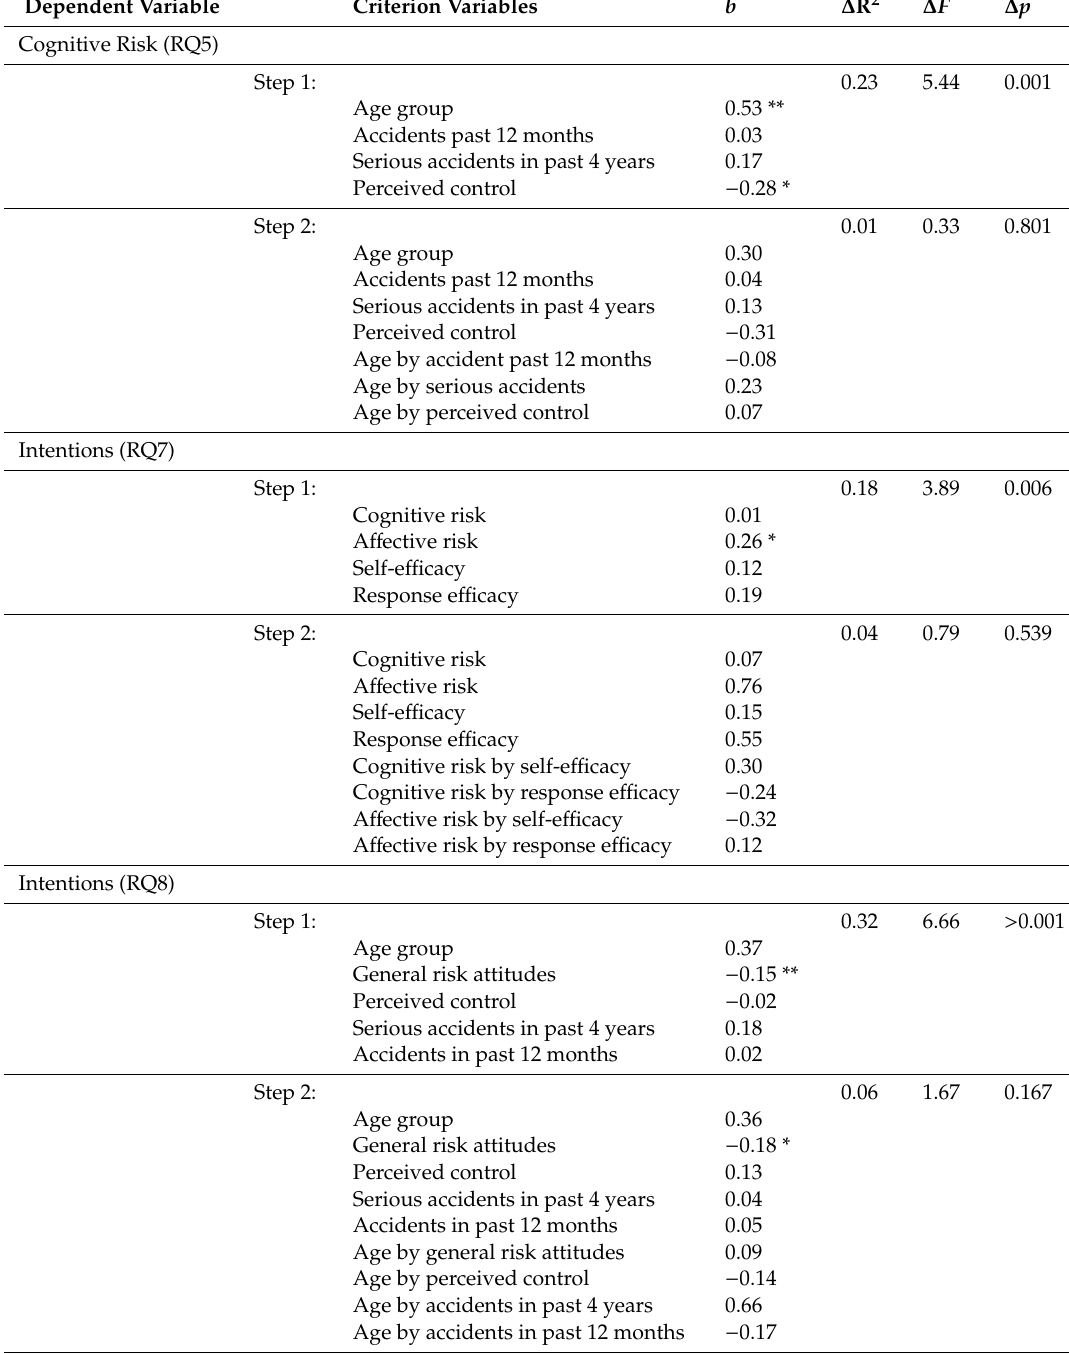
Table 2. Output details from the three hierarchical regression